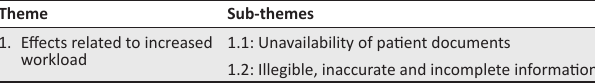
TABLE 1: Presentation of the findings: Theme and